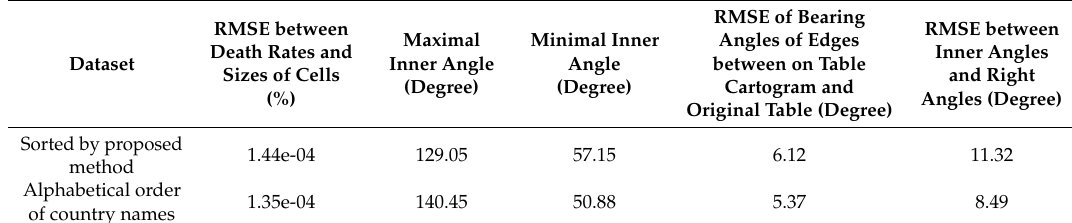
Figure 6. Quadrilateral table cartograms of death rate crude per thousand people by proposed method: ( a ) Rows are sorted by the proposed sorting method; ( b ) Alphabetical order of country names. Table 4. Data representation precision and shape deformation using arranged table and unarranged table by the proposed method (initial μ = 10).